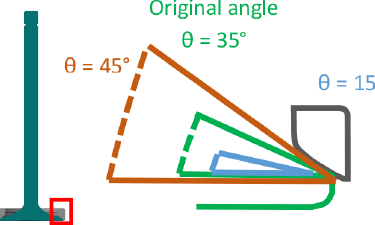
Fig. 22. De fi nition of the different contact angle used in the fi nite elements model to modify mechanical contact